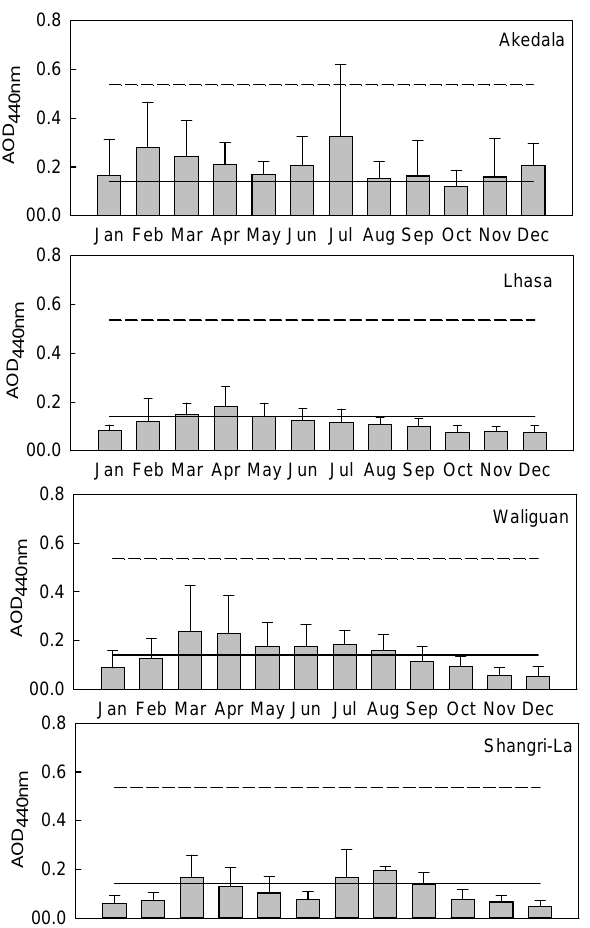
Figure 7. Monthly averaged AEs between 440 and 870nm at re- mote sites. The solid and dash horizontal hairlines indicate the an- nual averages for the subgroup and the whole database,